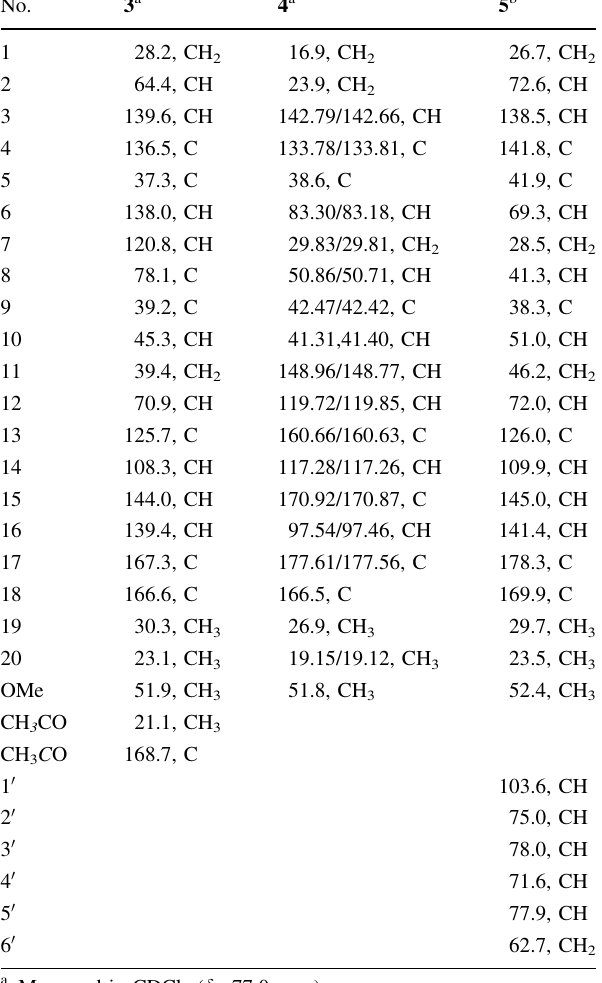
Table 4 13 C NMR spectroscopic data for 3 – 5